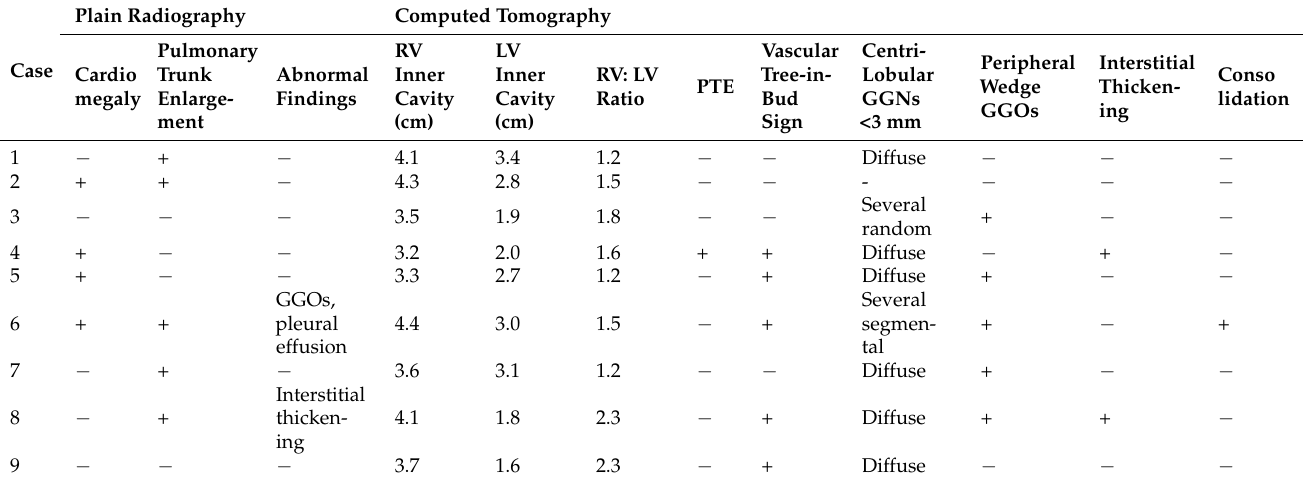
Abbreviations: GGNs, ground glass nodules; GGOs, ground-glass opacification; LV, left ventricle; PTE, pulmonary thromboembolism; RV, right ventricle; −, negative or none; +, positive or availa- ble.